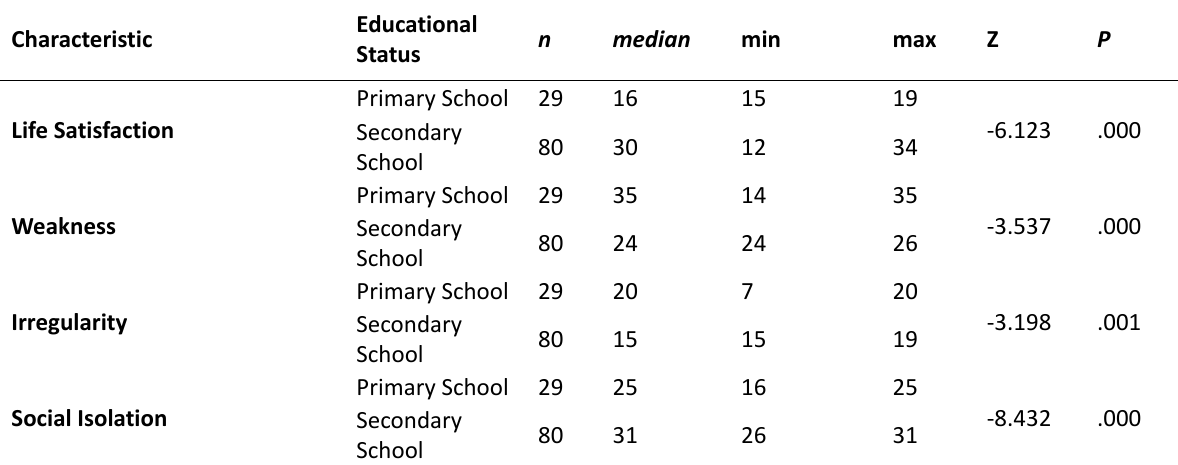
Table 5. Assessment of Participants’ Life Satisfaction and Alienation Level and Perceptions According to Their Educational Status Characteristic